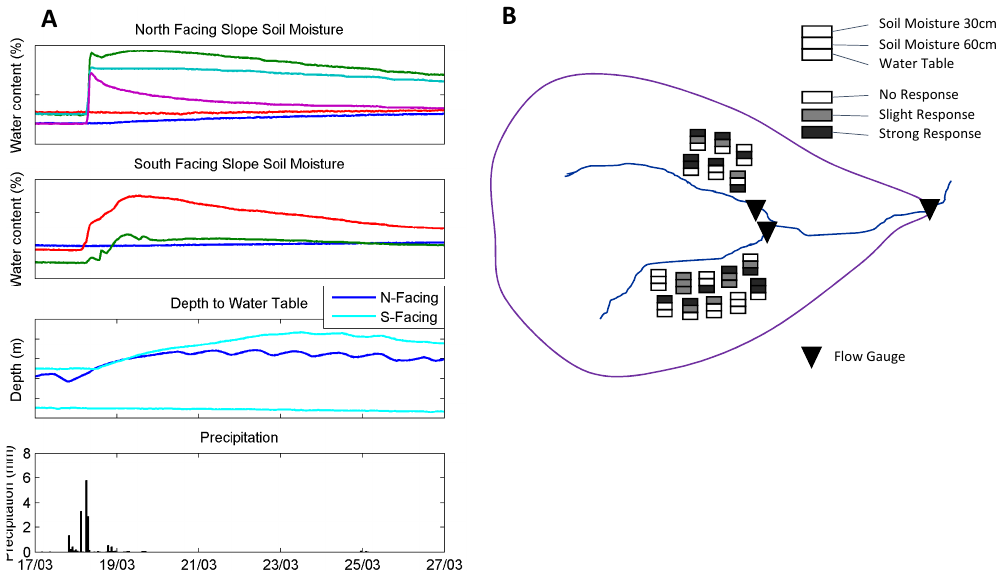
Figure 8. (a) Response of selected sensors to a March rainfall event. First and second panels: soil moisture responses in north-facing and south-facing slopes respectively. Colours are used only for visual clarity. Third panel: depth to water table. Fourth panel: storm precipitation. (b) Spatial overview of strength of soil moisture and water table sensor responses to the March rainfall